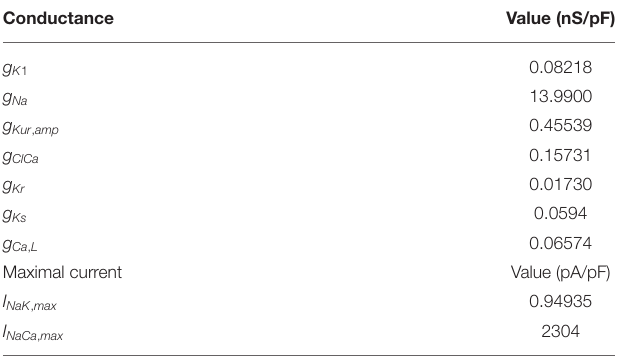
TABLE 2 | Conductance values and maximal currents after fitting restitution